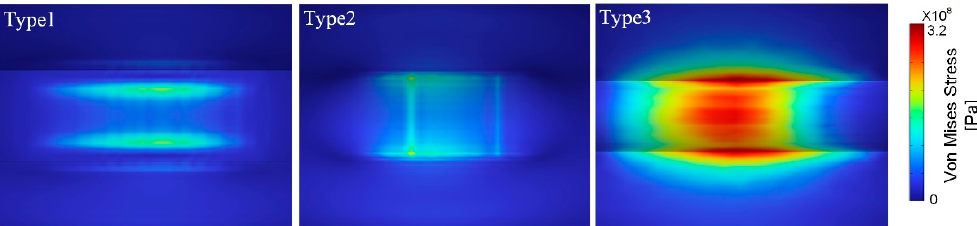
Figure 7. Von mises Stress distribution on the rails.